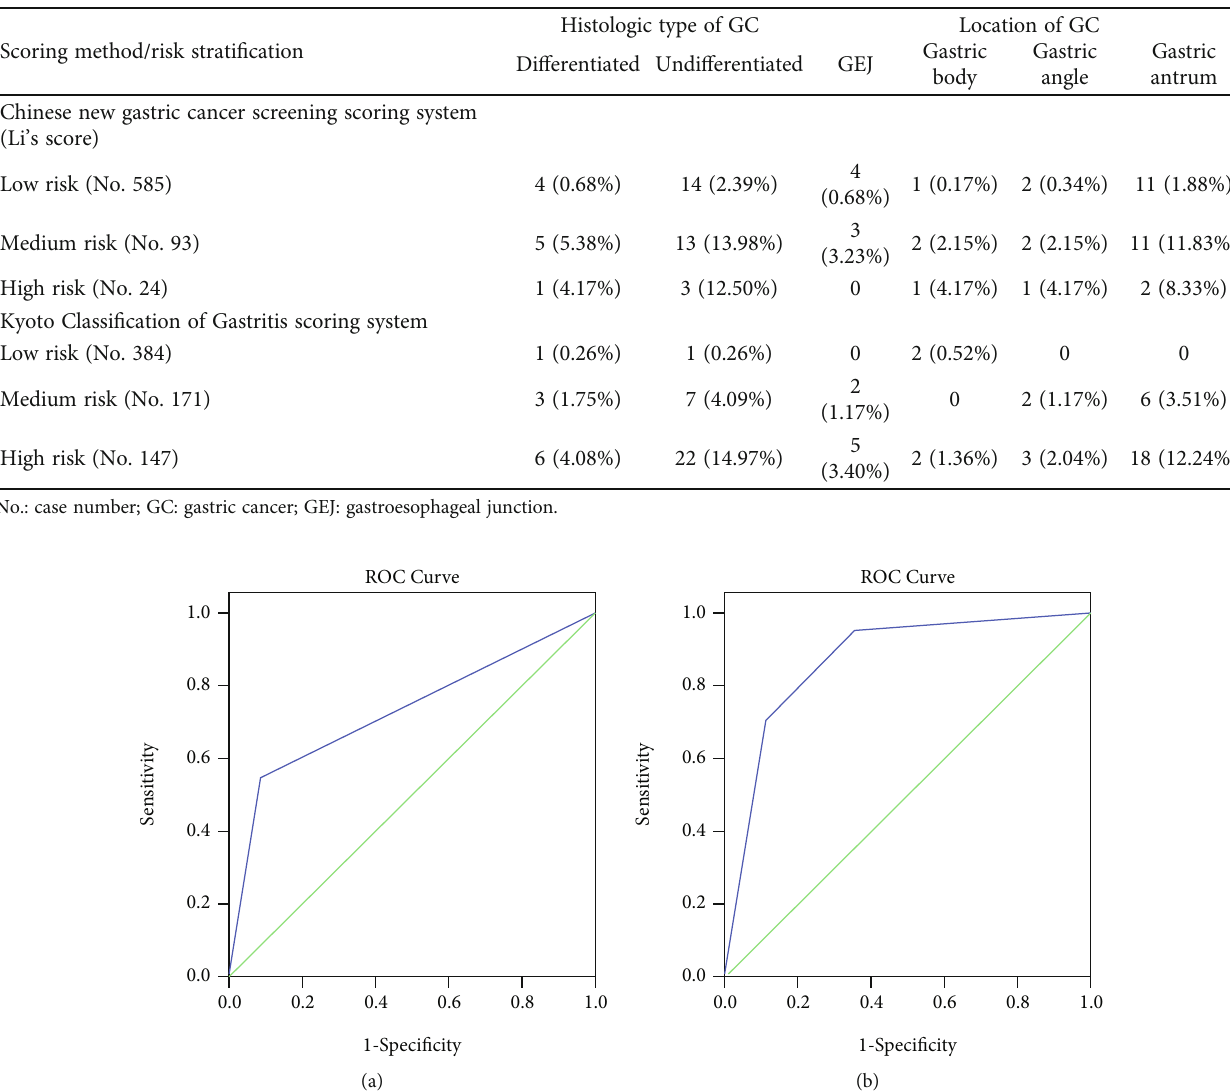
Table 6: Comparison of histologic type and location of gastric cancer results between the two scoring methods.